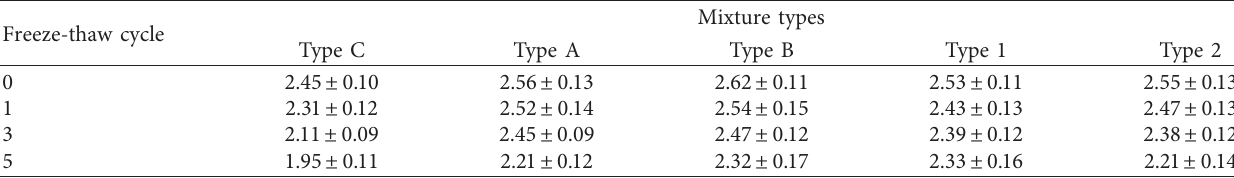
Table 4: The initial force of moisture damage asphalt mixtures (kN).